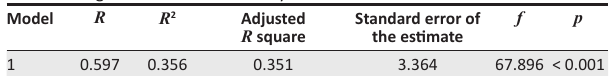
TABLE 5: Regression model summary.